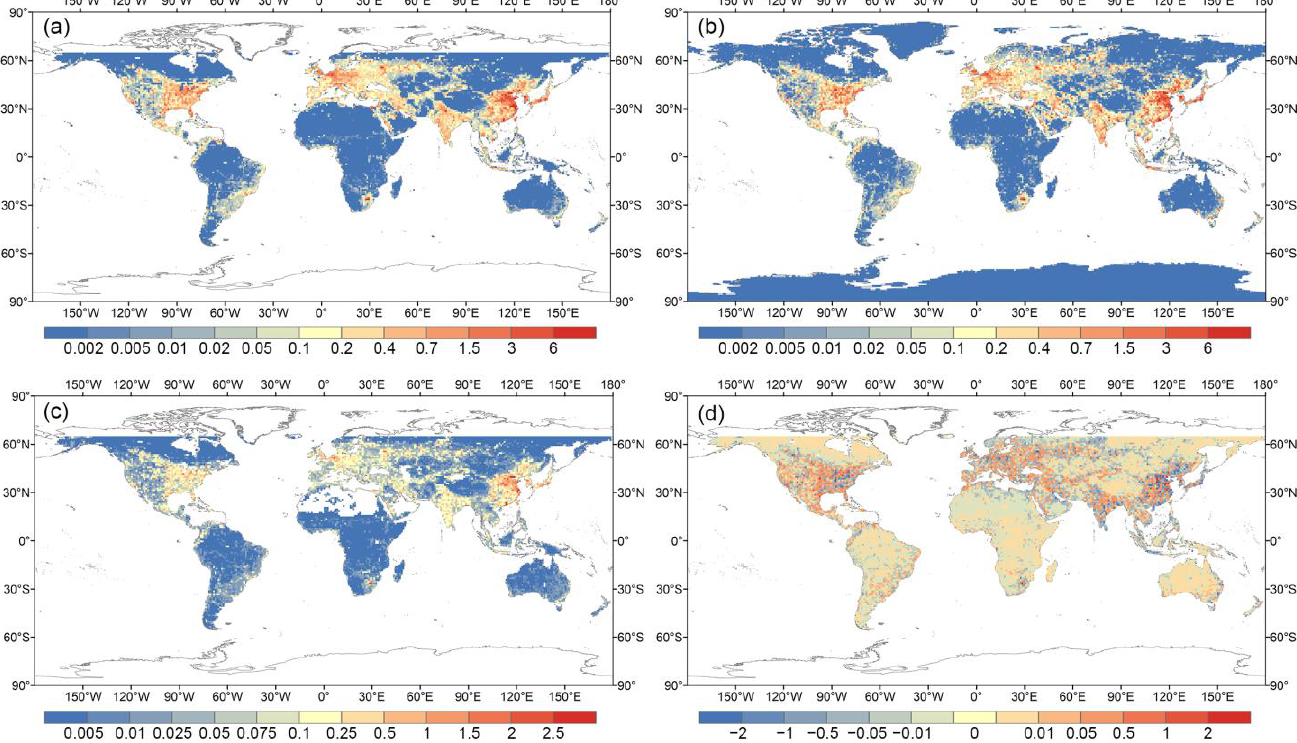
Figure 7. Spatial distribution of ( a ) the annual average of gridded global fossil fuel emission estimates in 2019, ( b ) the annual average of the ODIAC 1 ◦ data products in 2019, ( c ) the uncertainty of the estimated results, and ( d ) the difference between the estimate and the ODIAC data (estimate- ODIAC), in which a value greater than 0 indicated overestimation, and vice versa.